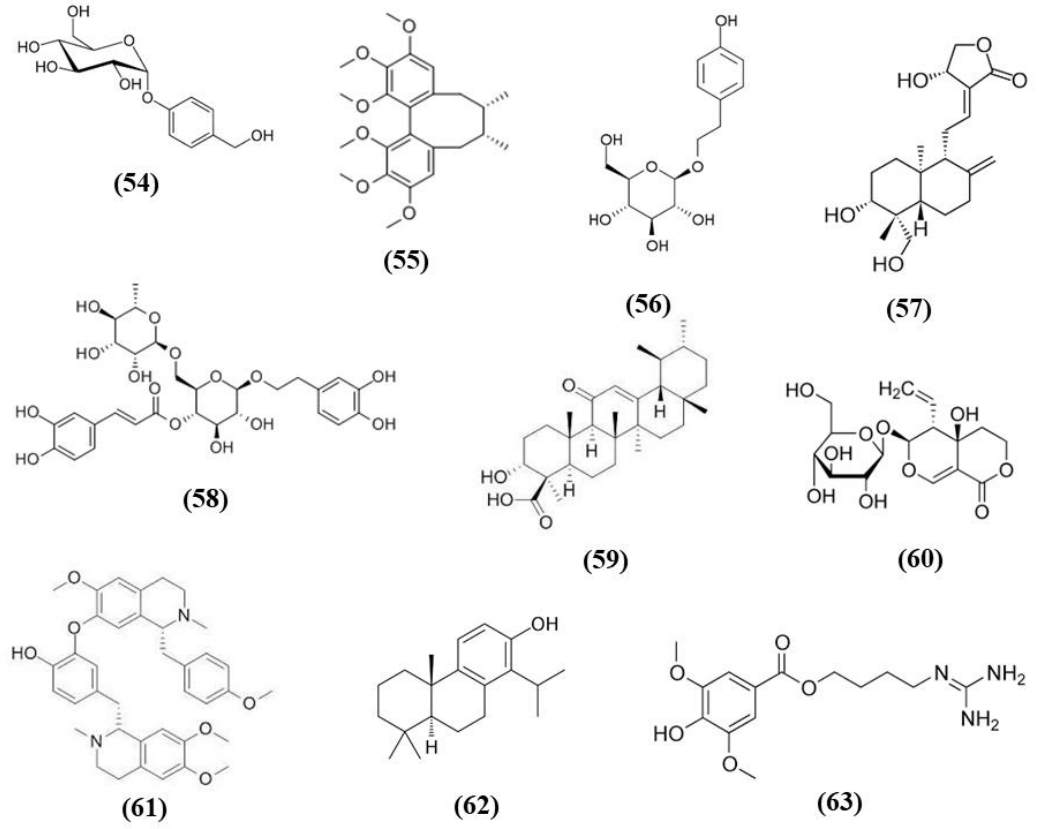
Figure 11. Chemical structure of ( 54 ) gastrodin, ( 55 ) schizandrin A, ( 56 ) salidroside, ( 57 ) andrographolide, ( 58 ) forsythiaside A, ( 59 ) 11-Keto- β -boswellic acid, ( 60 ) swertiamarin, ( 61 ) neferine, ( 62 ) totarol, and ( 63 )